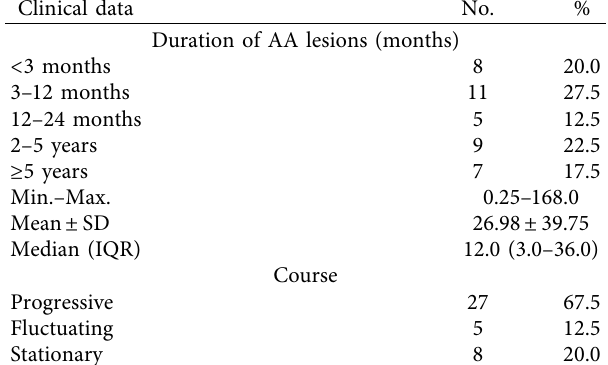
Table 1: Primers used for real-time polymerase reaction assay. Gene